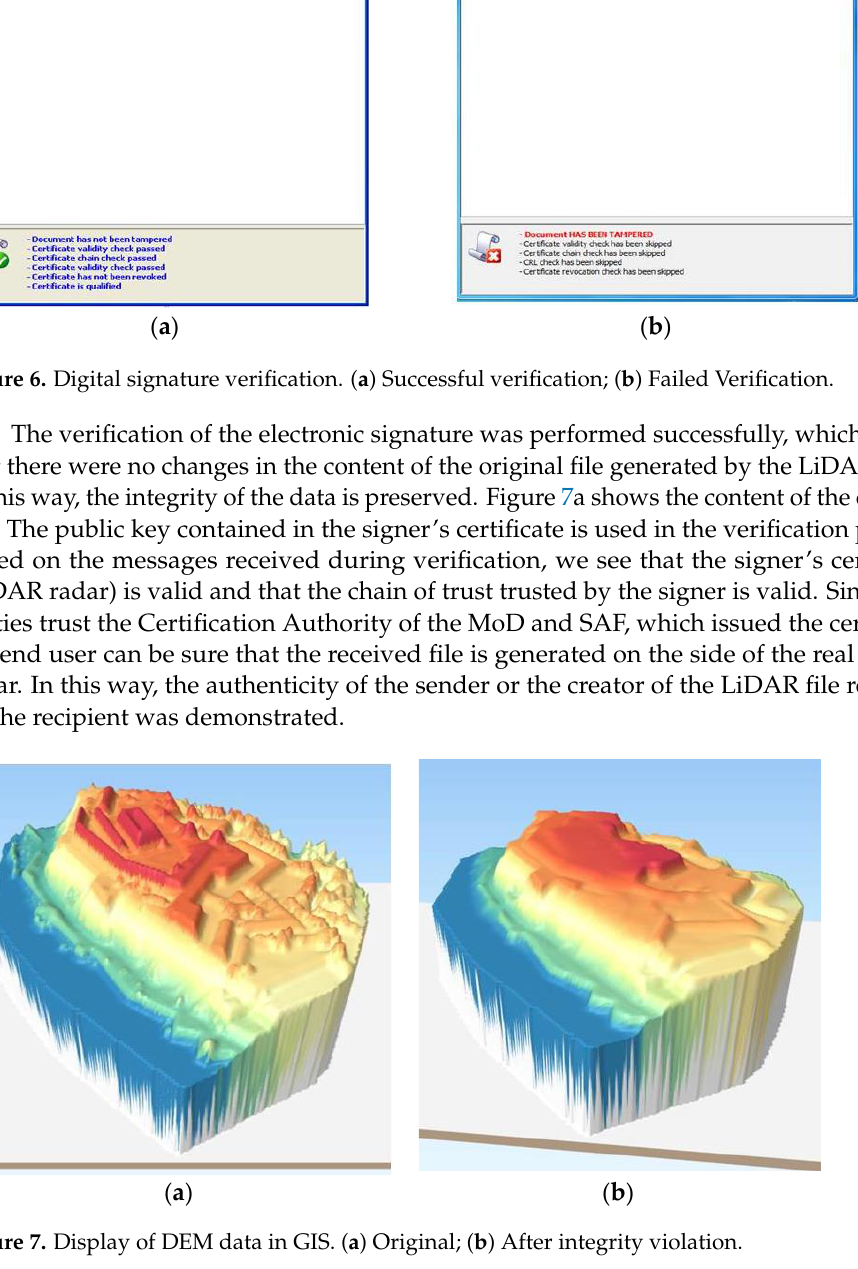
Figure 5. Digital certificates for end user. ( a ) Digital certificate for electronic signature; ( b ) Digital certificate for encryption.